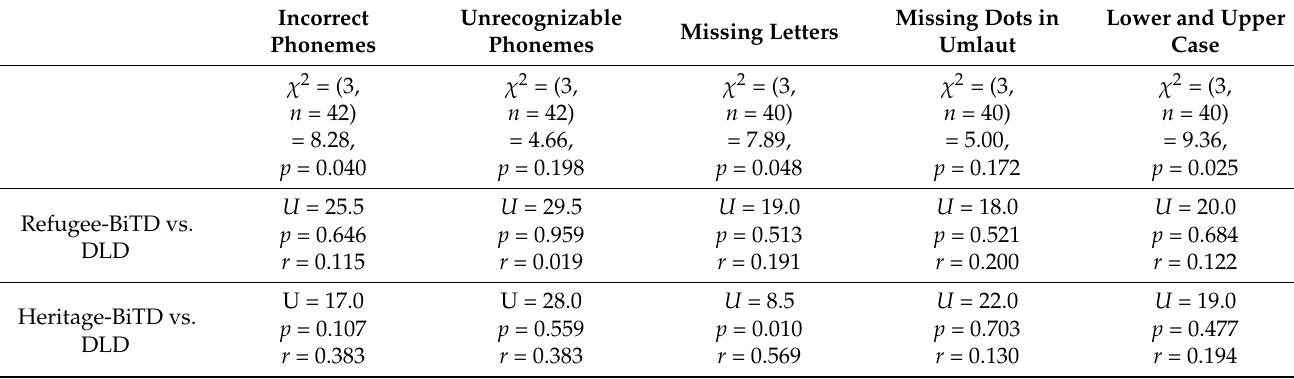
Table 5. Group comparisons for qualitative analysis of the subtest of spelling (Kruskal–Wallis tests and Mann–Whitney U